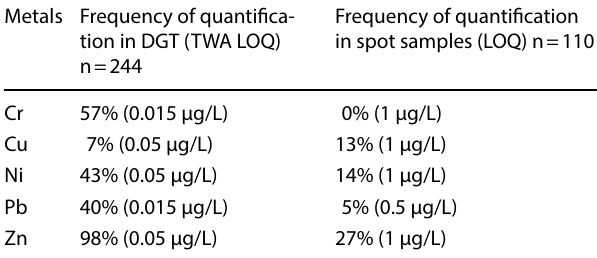
Table 1 Frequency of quantification in DGT and in spot samples for a selection of metals Metals Frequency of quantifica- tion in DGT (TWA LOQ) n = 244